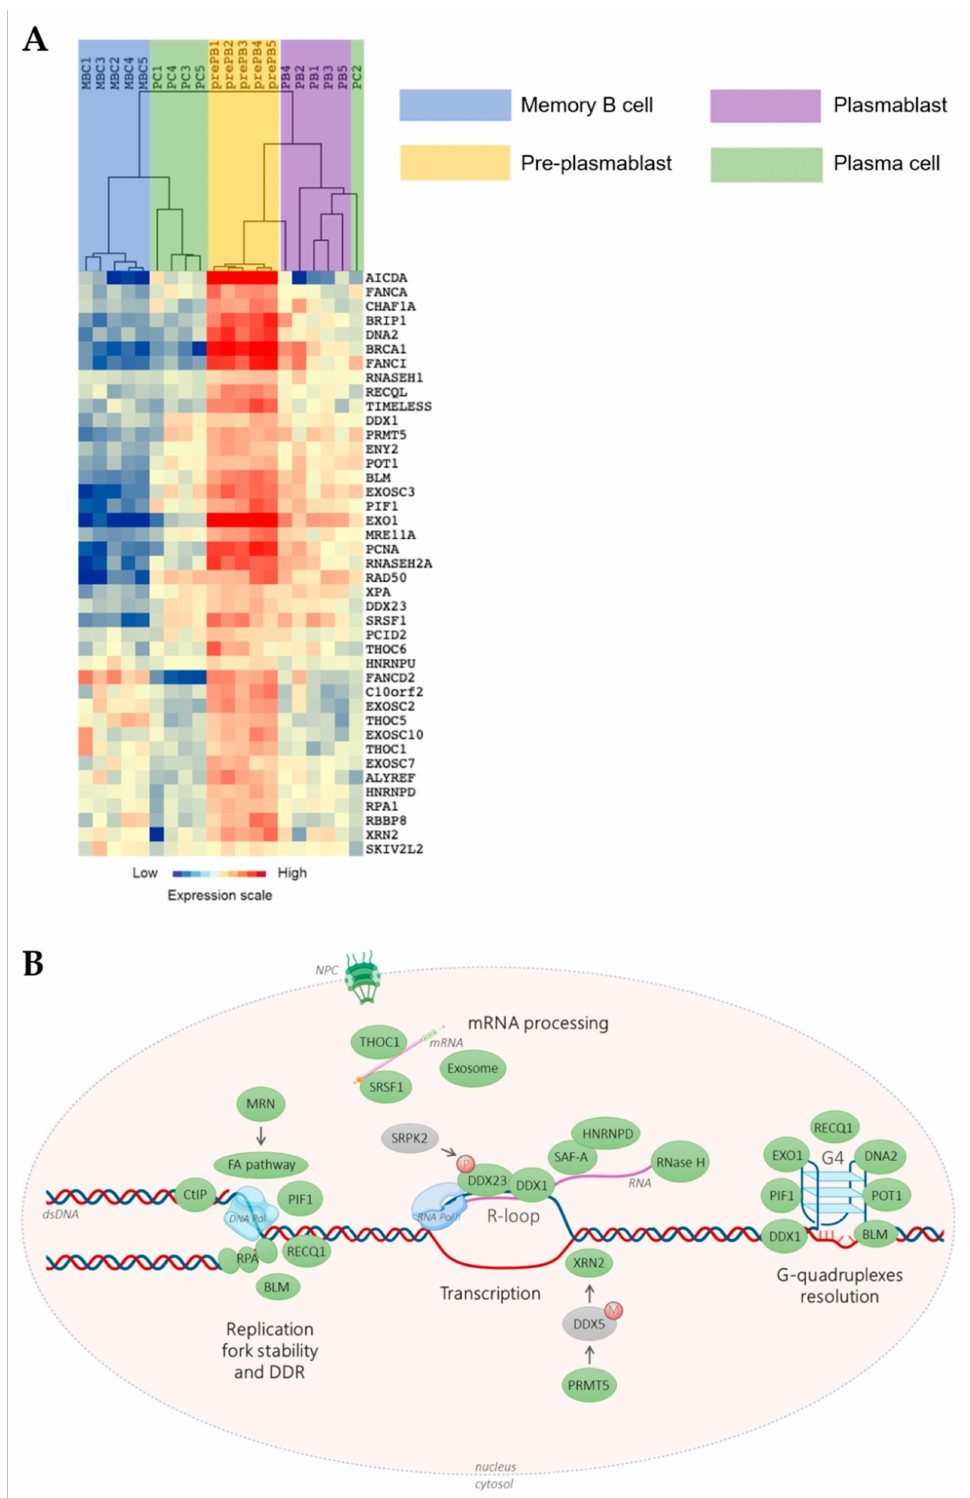
Figure 1. Transcription/replication conflicts (TRCs) resolution genes expression during memory B cells (MBCs) differentiation. ( A ) The genes significantly overexpressed in pre-plasmablasts (prePBs) compared to MBCs, PBs and plasma cells (PCs)